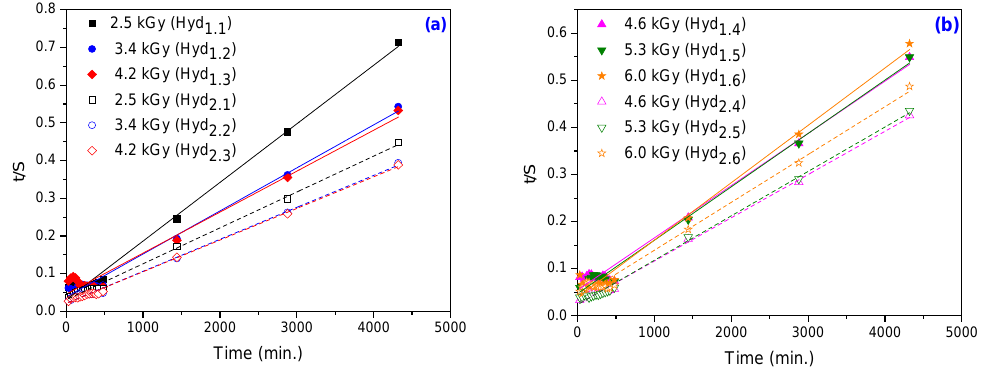
Figure 5. The first-order swelling kinetics for hydrogels obtained at: ( a ) 2.5 kGy, 3.4 kGy and 4.2 kGy; ( b ) 4.6 kGy, 5.3 kGy and 6.0 kGy.